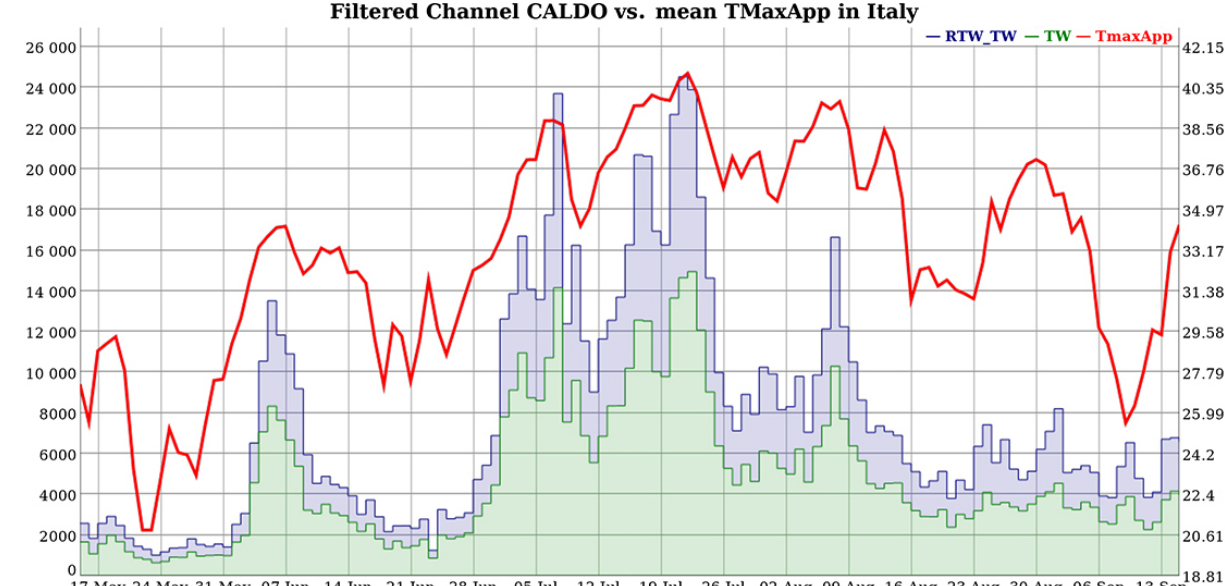
Figure 2. Number of Tweets and Retweets and the maximum apparent temperature (average of all stations) for Italy during the period 15 May and 15 September of 2015.